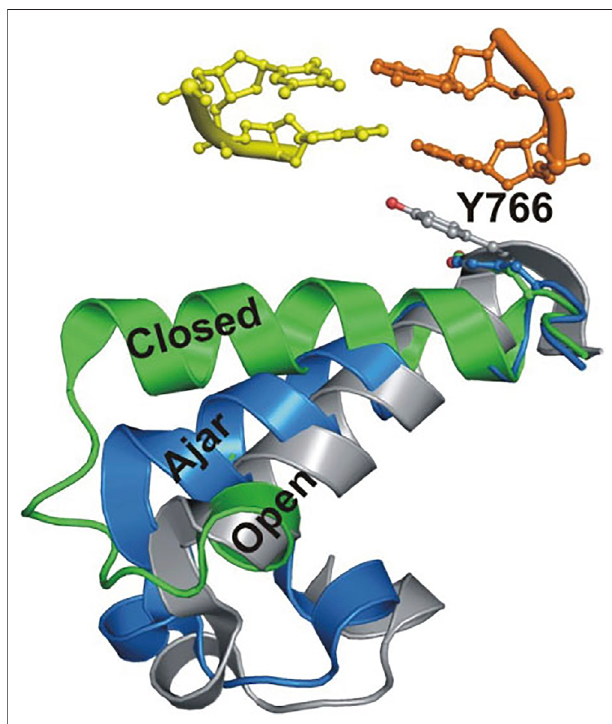
FIGURE3| Overlayofcrystalstructuresof Bst PolIrevealsthreedistinct conformations of the O-helix within the fi ngers domain. Adapted from reference (Berezhna et al., 2012) with